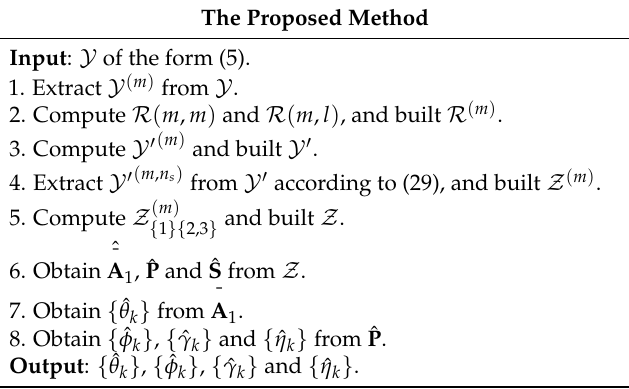
Table 1. The overall procedure of the proposed